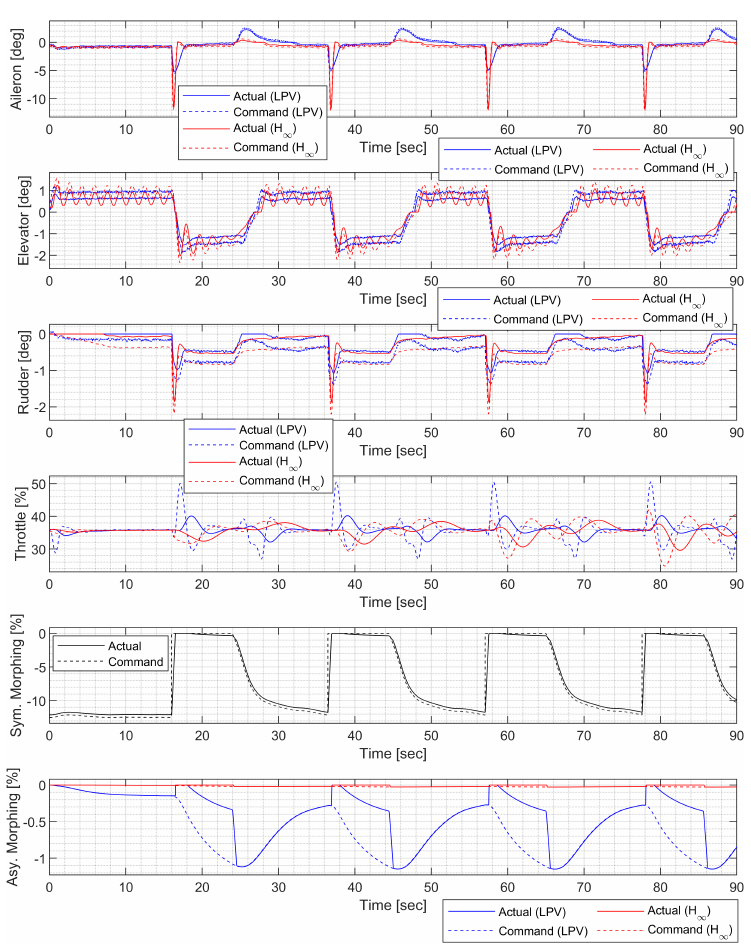
Figure 22. Input history of the waypoint-following